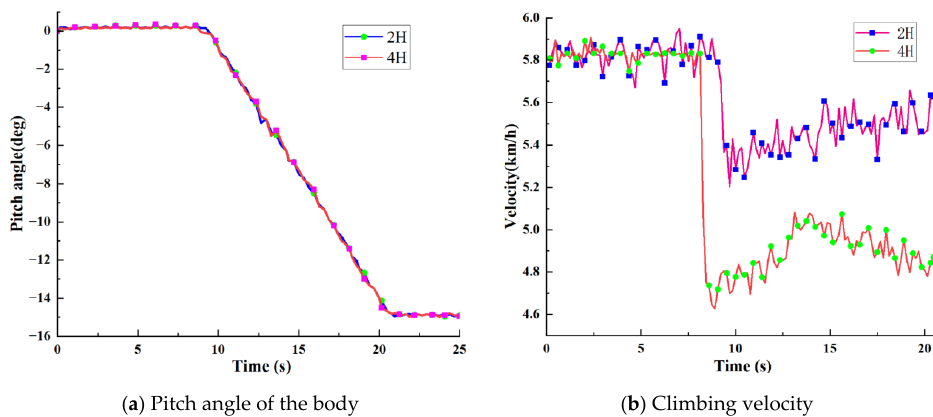
Figure 13. The climbing experiment of HGPM.